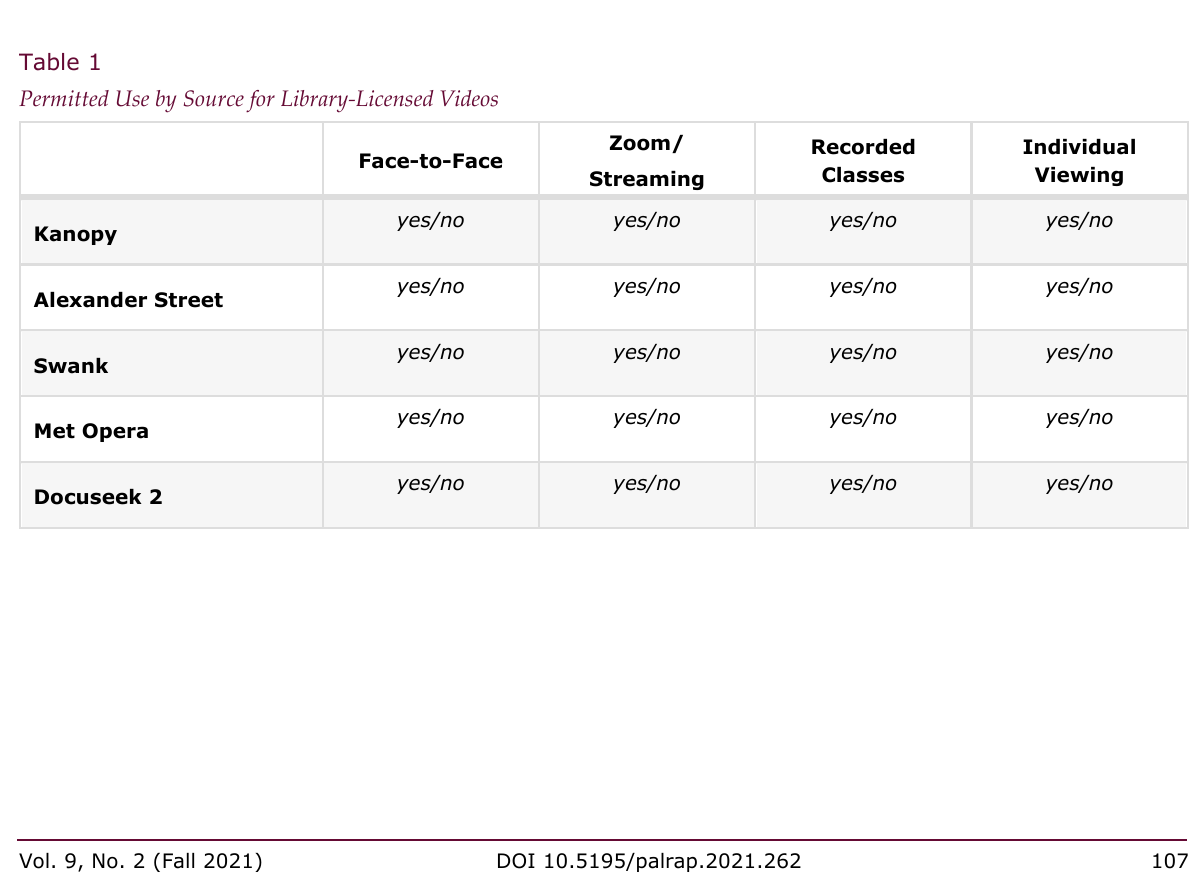
Permitted Use by Source for Library-Licensed Videos